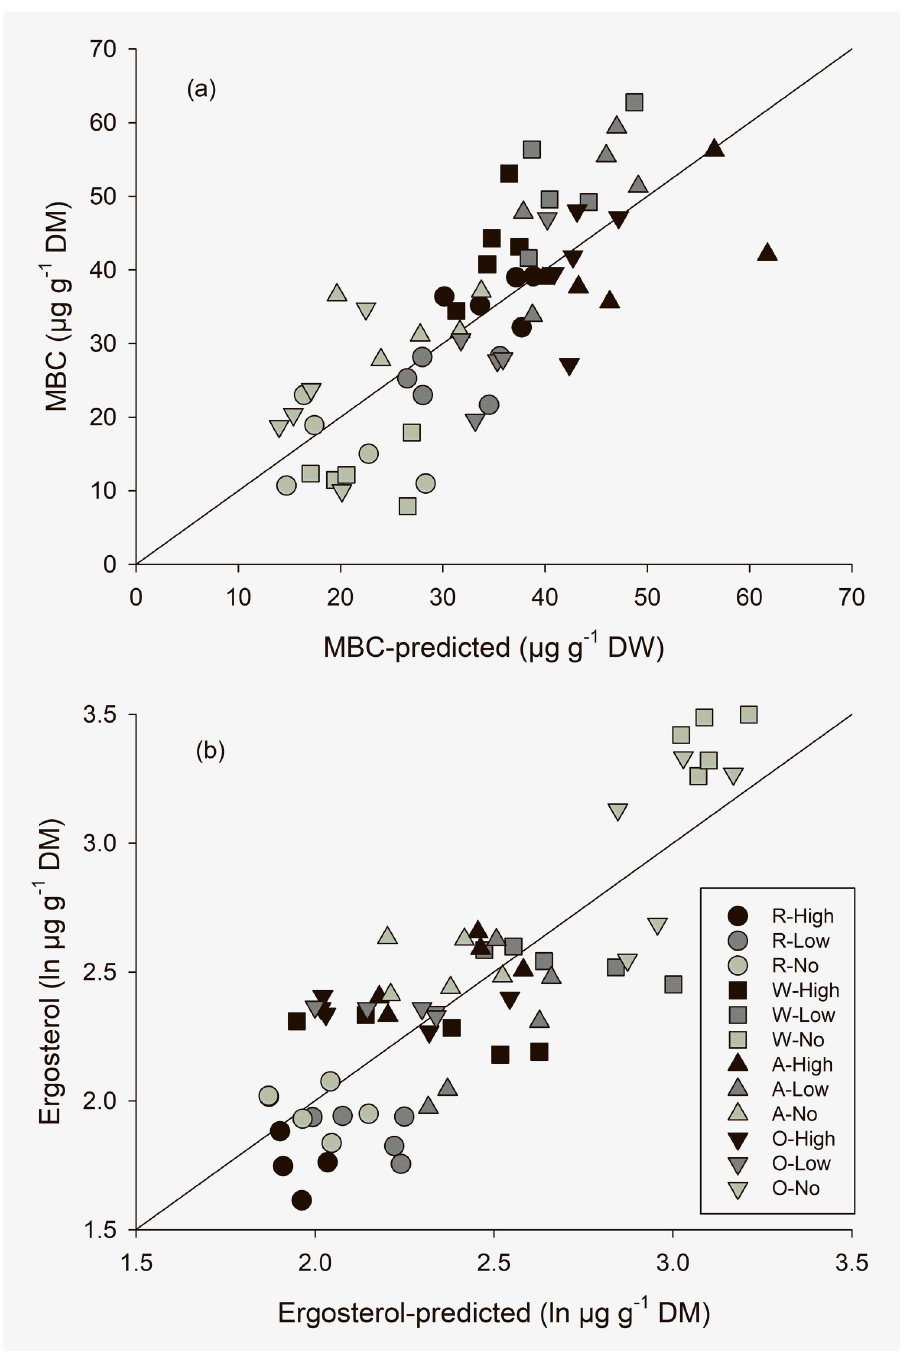
Fig 1. Multiple linear relationship between (a) MBC and (b) ergosterol and the chemical composition of cow faeces, see Table 6 for the equations.